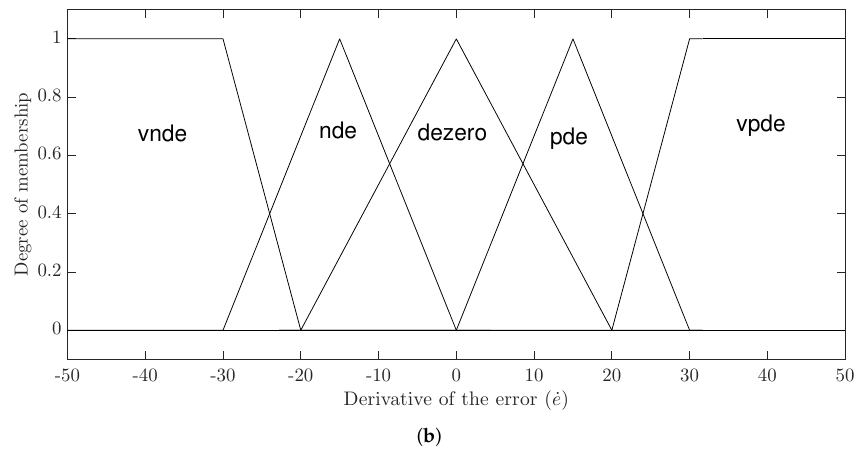
Figure 3. Membership functions for input variables. ( a ) Error; ( b ) derived of the error.